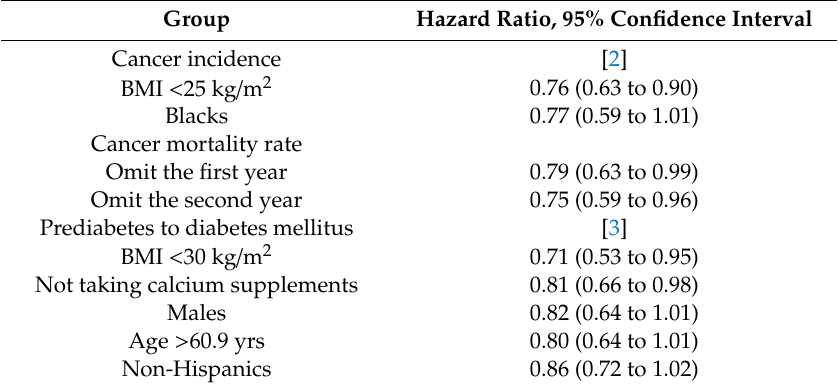
Table 1. Secondary outcomes from two recent large vitamin D randomized controlled trials